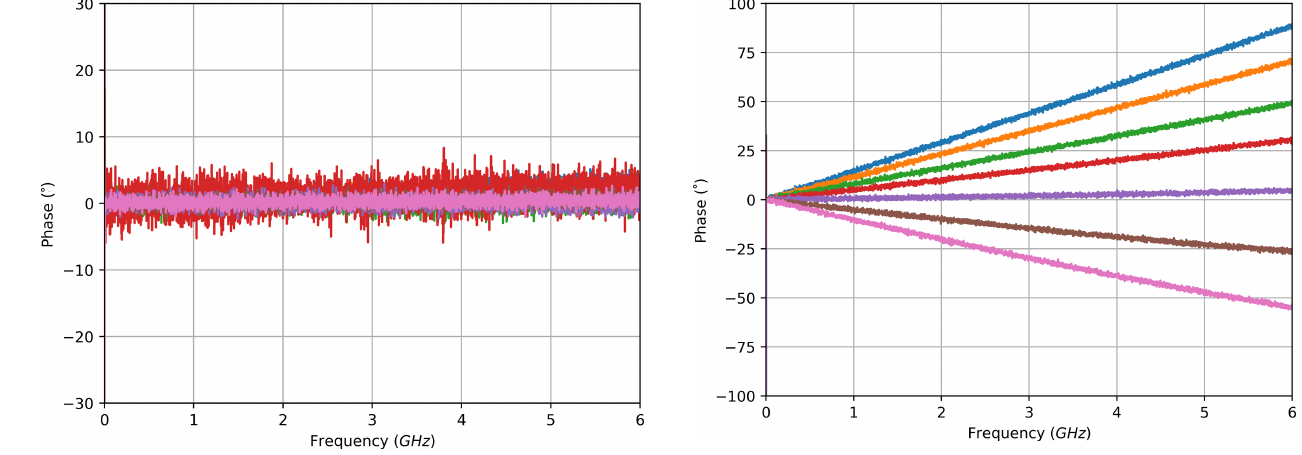
Figure 12. Electrical phase of S21 measurements of a cFBG in transmission configuration.